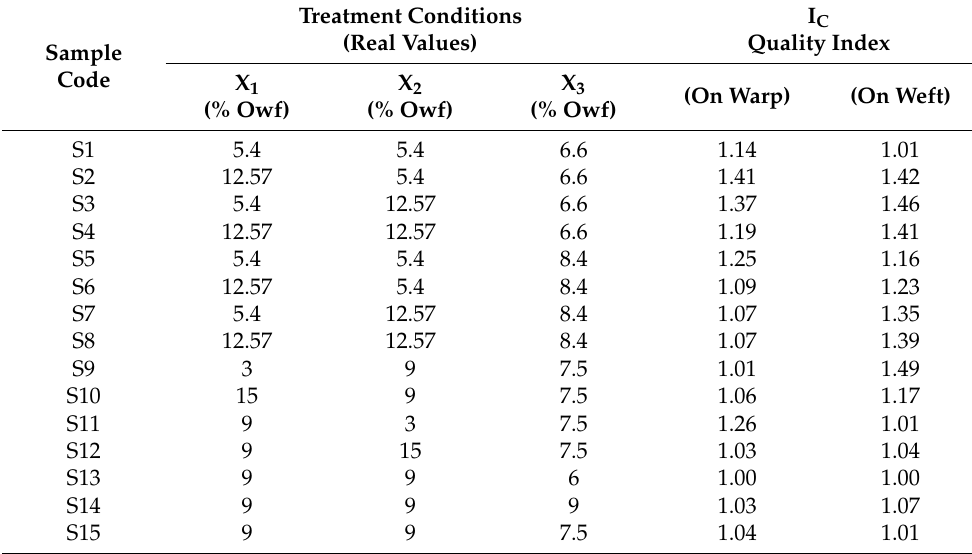
Table 6. The values of index I C